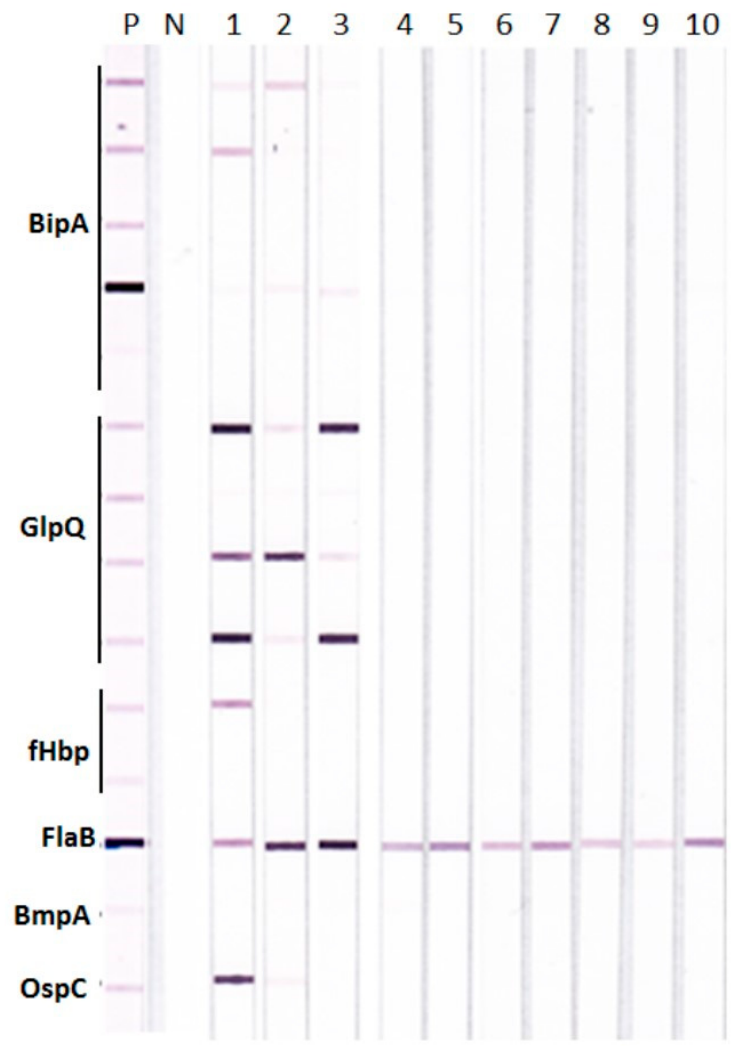
Figure 1. Tick-borne relapsing fever immunoblots (TBRF IBs) with rabbit antisera to di ff erent Borrelia species. Rabbit antisera produced against di ff erent relapsing fever Borreliae (RFB) (lanes 1–3) and Lyme disease Borreliae (LDB) (lanes 4–10) were tested individually on TBRF IBs. Rabbit antibodies to: Lane 1, B. hermsii ; lane 2, B. turcica ; lane 3, B. coriaceae ; lane 4, Bbss strain B31; lane 5, Bbss strain 297; lane 6, B. afzelii ; lane 7, B. garinii ; lane 8, B. californiensis ; lane 9, B. spielmanii ; and lane 10, B. valaisiana . P, positive control pooled rabbit antiserum and N, negative control human serum.